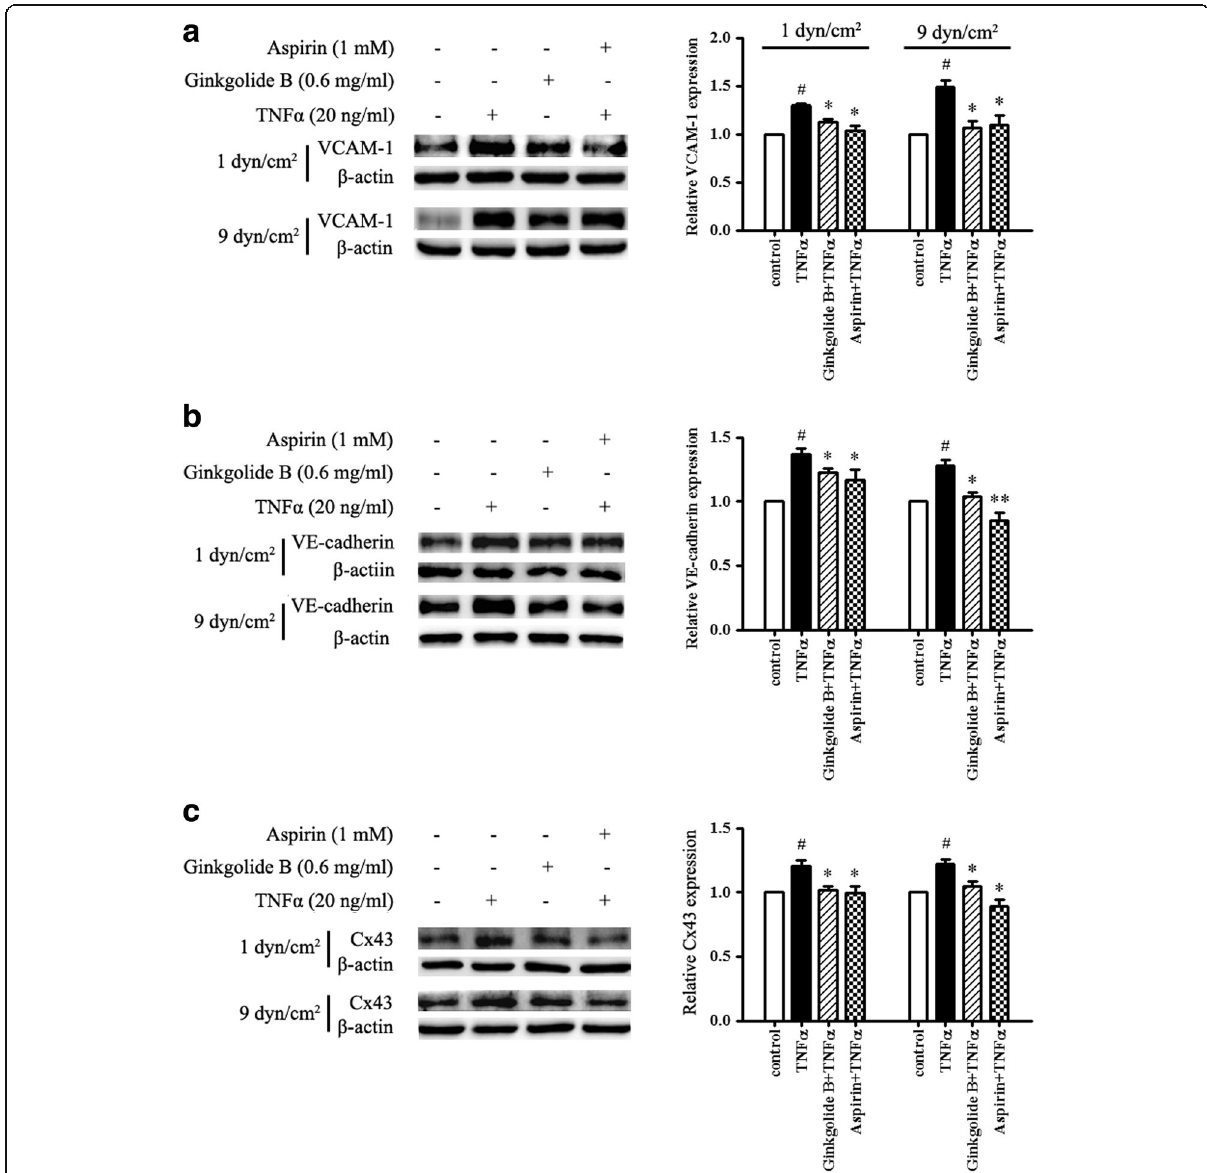
Fig. 4 Ginkgolide B suppressed VCAM-1, VE-cadherin, and Cx43 expression in TNF α -treated HUVECs that presented monocyte adhesion under different conditions of laminar shear stress. HUVECs were incubated with ginkgolide B (0.6 mg/ml) or aspirin (1 mM) for 12 h, and then TNF α (20 ng/ml) was added for another 2 h. The monocyte suspension was then added to the input well at 1 and 9 dyn/cm 2 of laminar shear stress for 45 min. Unadhered monocytes were removed by the addition of PBS buffer for 2 min. Lysates were then collected by the addition of lysis buffer. Protein expression was analyzed by Western blot. a Ginkgolide B inhibited TNF α -induced VCAM-1 expression at 1 and 9 dyn/cm 2 . b Ginkgolide B decreased TNF α -induced VE-cadherin expression at 1 and 9 dyn/cm 2 . c Ginkgolide B reduced TNF α -induced Cx43 expression at 1 and 9 dyn/cm 2 . # p < 0.05, significant difference between TNF α -treated and -untreated HUVECs. * p < 0.05, ** p < 0.01, significant difference between TNF α -treated cells and ginkgolide B- and aspirin-treated